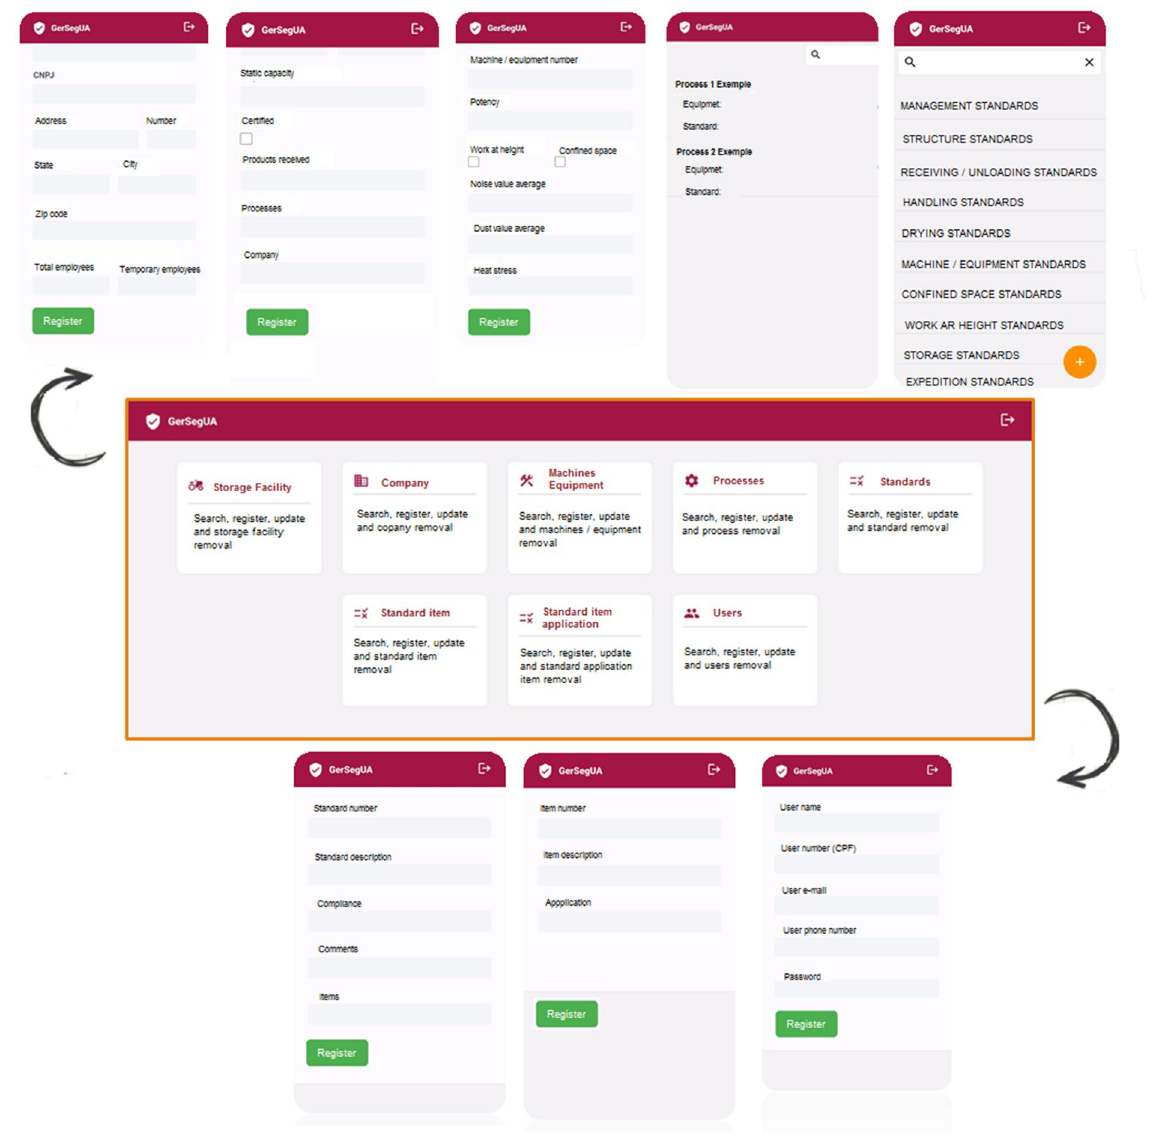
Figure 11. Algorithm to manage occupational safety at grain handling and storage facilities register